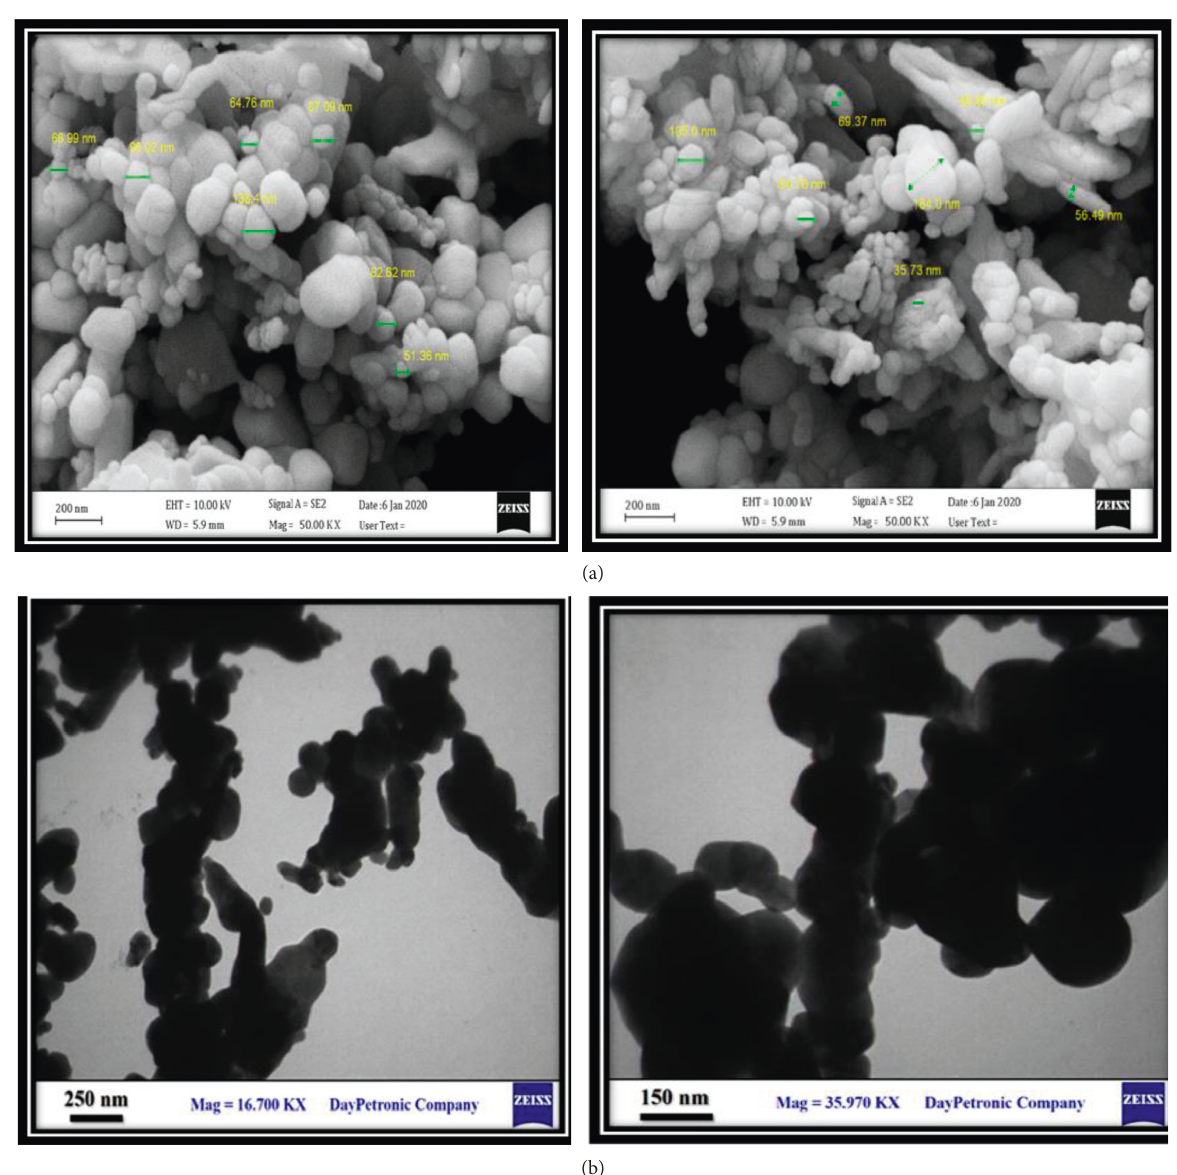
Figure 2: Scanning electron microscopy (SEM) (a) and transmission electron microscopy (TEM) (b) of CuO NPs.